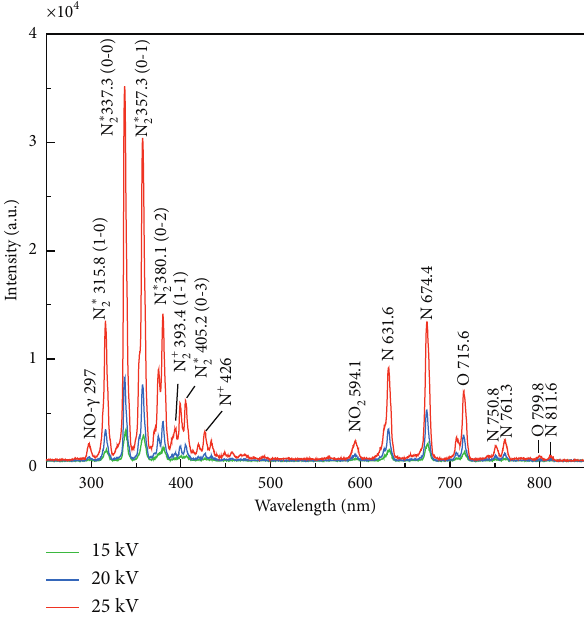
Figure 5: Plasma emission